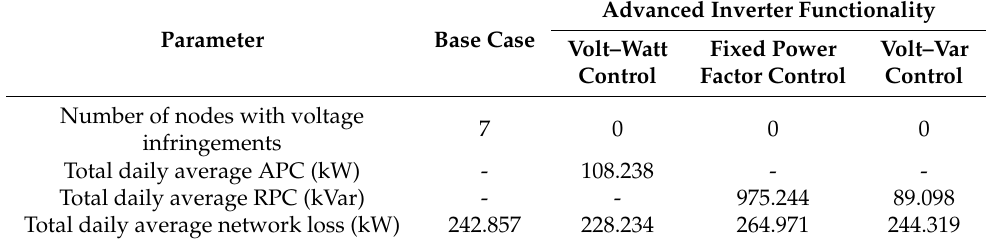
Table 2. Simulation